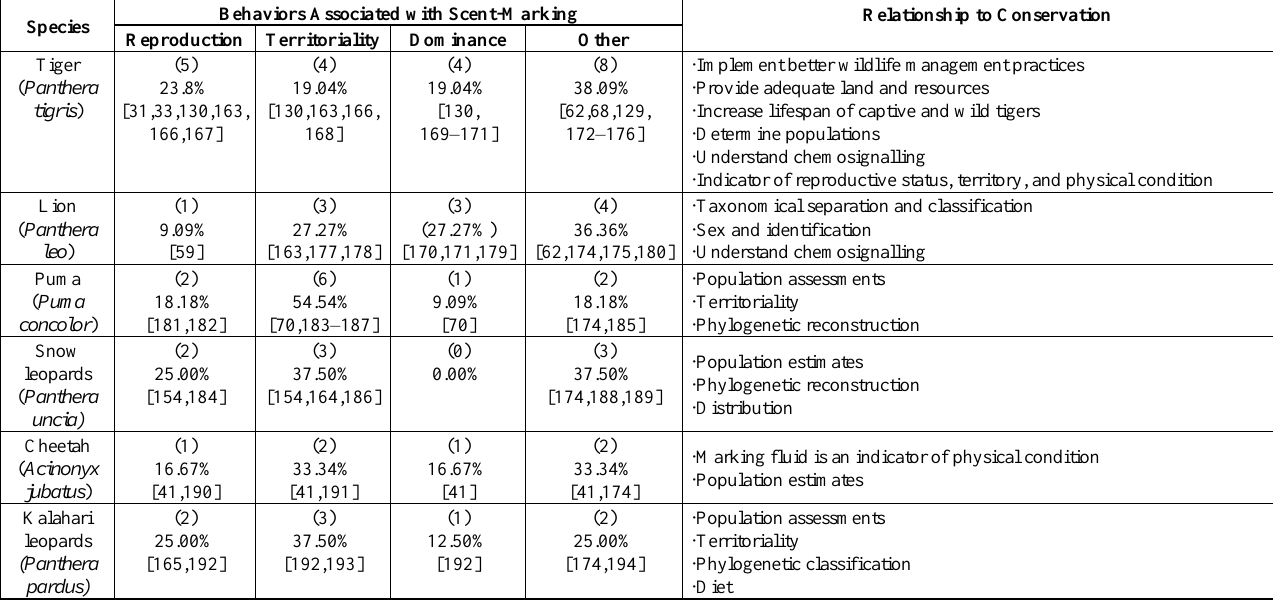
Table 3. Number/percentage of articles that focus on categorizing scent-marking behaviors in wild cats and their relationships to